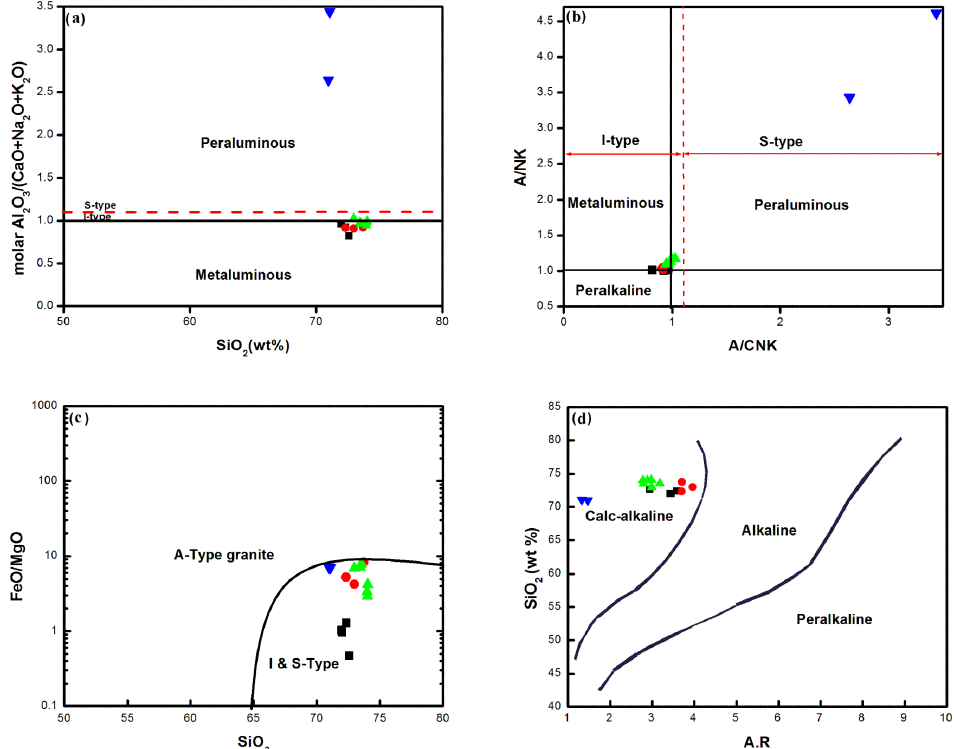
Figure 6. ( a ) Al 2 O 3 / (CaO + Na 2 O + K 2 O) vs. SiO 2 classification diagram for peraluminous and meta-aluminous [52] and I and S-type granites [53]. Solid horizontal and dotted lines indicate a molar alkalinity of 1 and a boundary between I- and S-type granitoids. ( b ) Alumina index diagram for granitoids and Roche type rock (the boundary between I- and S-type granites are after [54]. Solid vertical and dotted lines mark the boundary between alkalinity of 1 and a boundary between I- and S-type granitoids ( c ) Data of the Tianshui granitoids and Roche type rock plotted on the SiO 2 vs. FeO/MgO diagram of [55], indicating I- and S-type origin. ( d ) SiO 2 vs. alkalinity ratio (A.R) diagram after [56] on which all the studied samples plot in the calc-alkaline field.